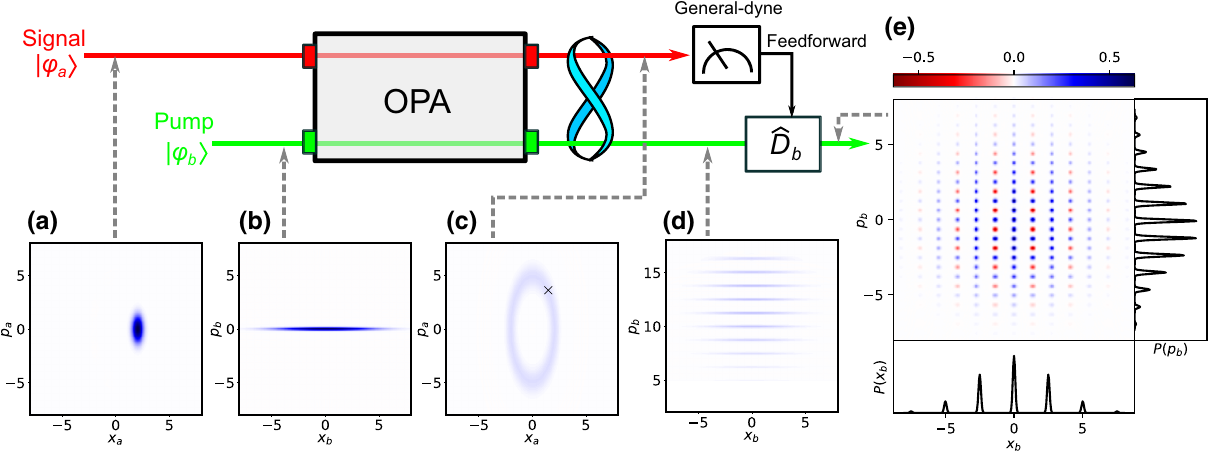
FIG. 3. Generation of a symmetric GKP state with 15 dB of squeezing using nonlinear quantum dynamics of an OPA. The initial signal state is | A 0 (cid:5) [shown in (a)], and the pump state, which is instantiated as a 15-dB p -squeezed vacuum [shown in (b)], interact through a frequency-detuned quadratic OPA Hamiltonian. A complete general-dyne measurement is performed on the final signal mode [shown in (c)] to measure the phase of the signal Bogoliubov excitation φ . Conditioned on the phase measurement outcome, the final pump state [shown in (d)] collapses to an approximate GKP state up to extra displacements, which can be compensated by feedforward operations. The Wigner function and the marginal quadrature distributions of the resultant approximate GKP state are shown in (e). We assume a signal measurement outcome of (cid:14) = 0.1 and φ = π/ 4, whose centroid is indicated by a black cross in (c). For the simulations, we use the Hamiltonian (7) with ˜ g / g = 1.0 and (cid:9) =